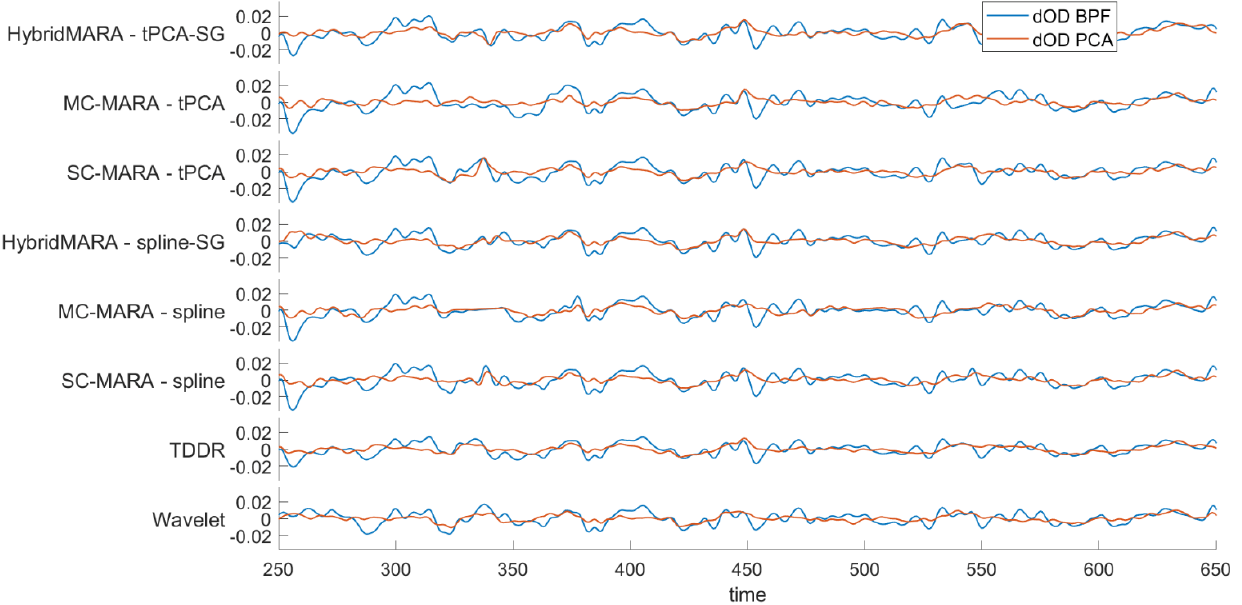
Figure 6. Single-channel graphical representation of the effect of PCA over Δ 𝑂𝐷 signals across pipelines. Δ𝑂𝐷 signals are represented with respect to the BPF signals (blue line-input signal) and after PCA step (red line-output signal).